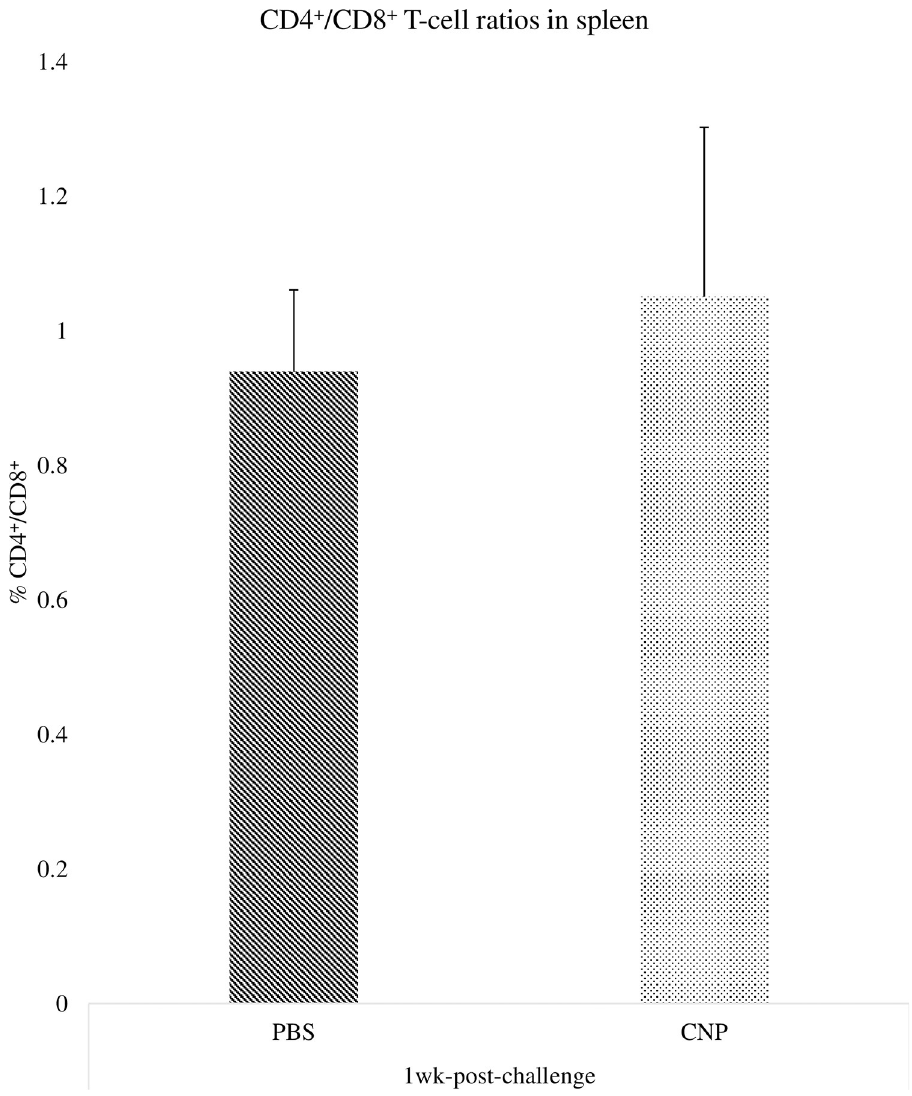
forward-scatter and side-scatter plot for lymphocytes. Data analyzed by parametric Student t-test; Means+SEM.Bars. n = 6. " � " means P <